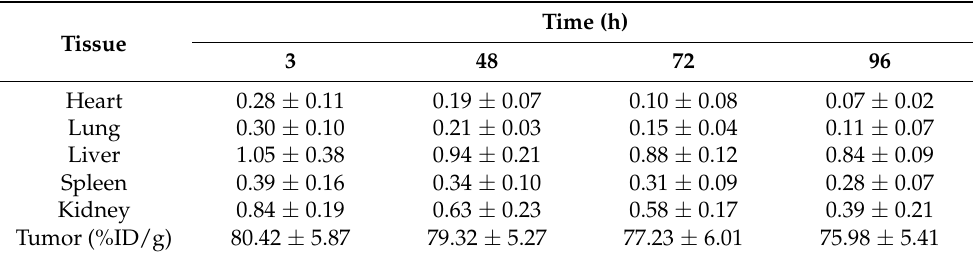
Table 4. Biodistribution (% injected dose) at various time points of 177 Lu 2 O 3 -iFAP in nude mice bearing HCT116 tumors (mean ± SD) ( n = 3), after intratumoral injection. Table 3. Biodistribution (% injected dose) at various time points of 177 Lu 2 O 3 -iPSMA in nude mice bearing HCT116 tumors (mean ± SD) ( n = 3), after intratumoral injection.